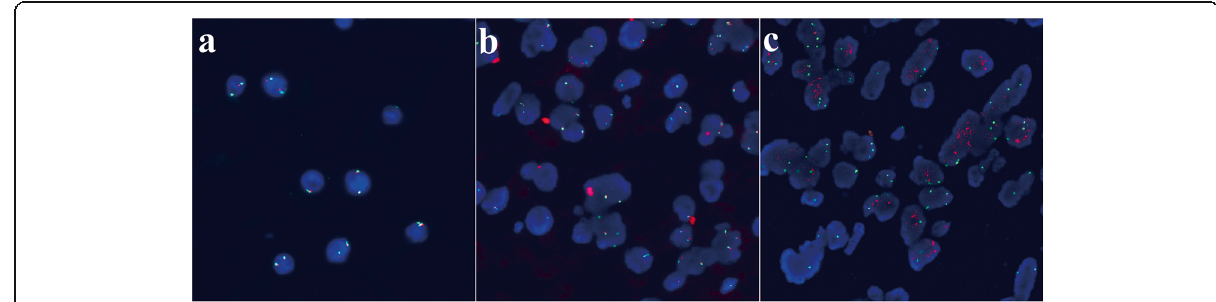
Fig. 4 The fluorescence in situ hybridization study showed no evidence of the EGFR gene amplification (a). Negative control (b) and positive control (c) were set